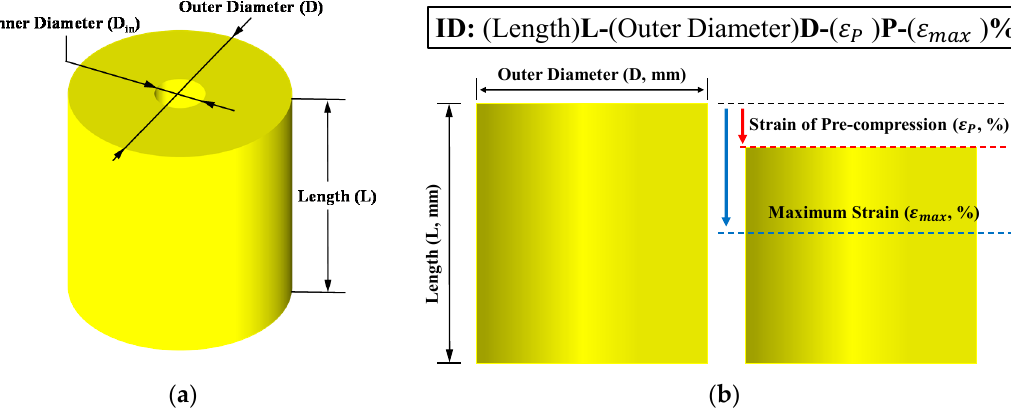
Figure 1. Design of experimental specimens . ( a ) Isometic view. ( b ) Identification ( ID ) of specimens.